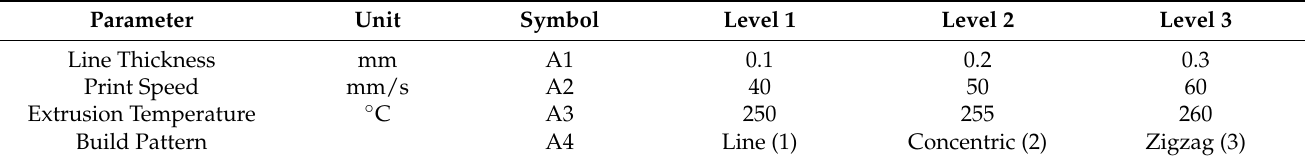
Table 3. FFF 3DP parameters used to print ABS polymer